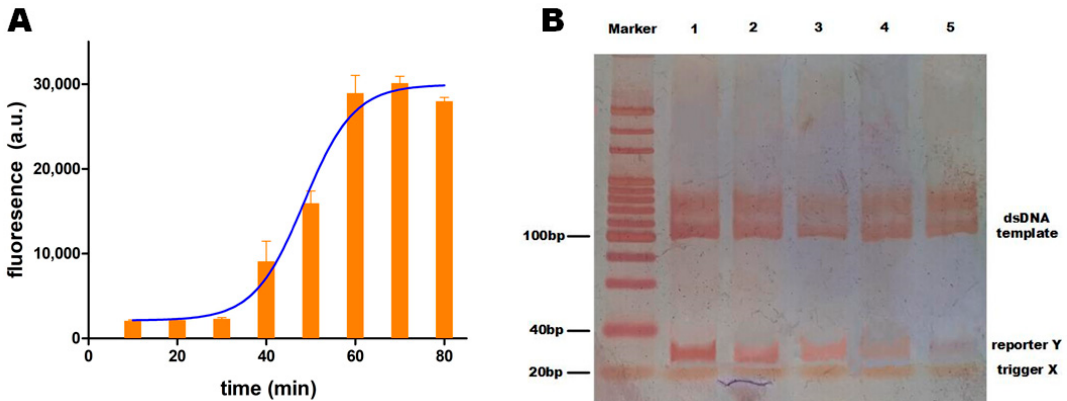
Figure 1. Effect of different reaction periods on EXPAR (Exponential Amplification Reaction). ( A ) EXPAR fluorescence signals monitored by DEAOU real-time fluorescence detector; ( B ) EXPAR results were verified using non-denatured PAGE. The leftmost side of the gel was 20 bp Marker, and lanes 1 – 5 represent the EXPAR results at 60, 50, 40, 30, and 20 min, respectively.